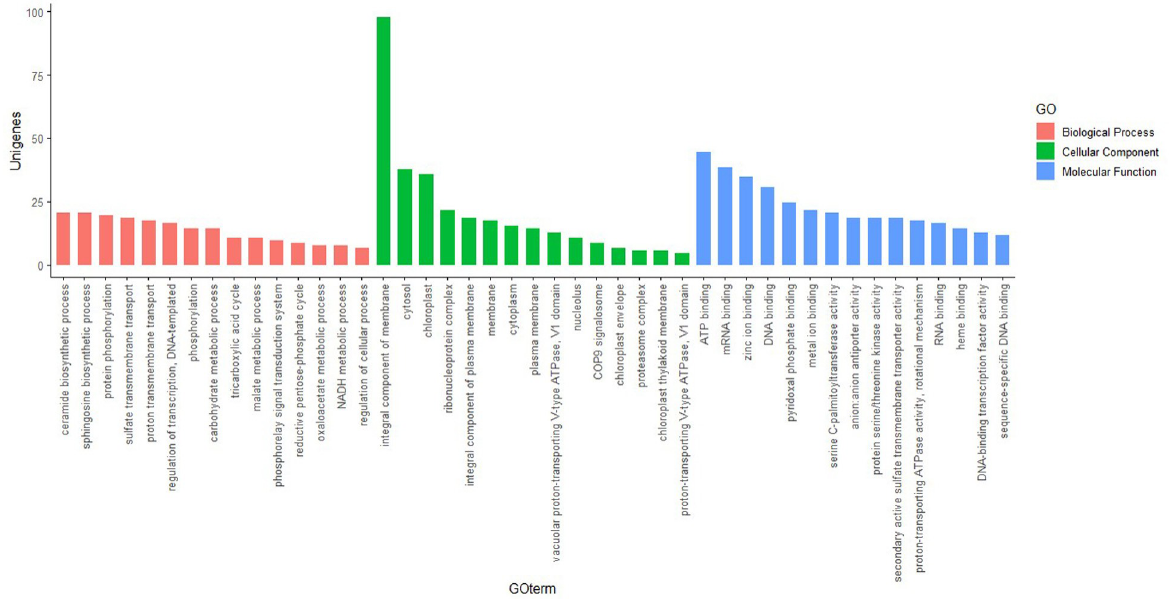
Fig 3. Gene Ontology classification of unigenes. Unigenes were assigned to three categories: cellular component, molecular function, and biological process.